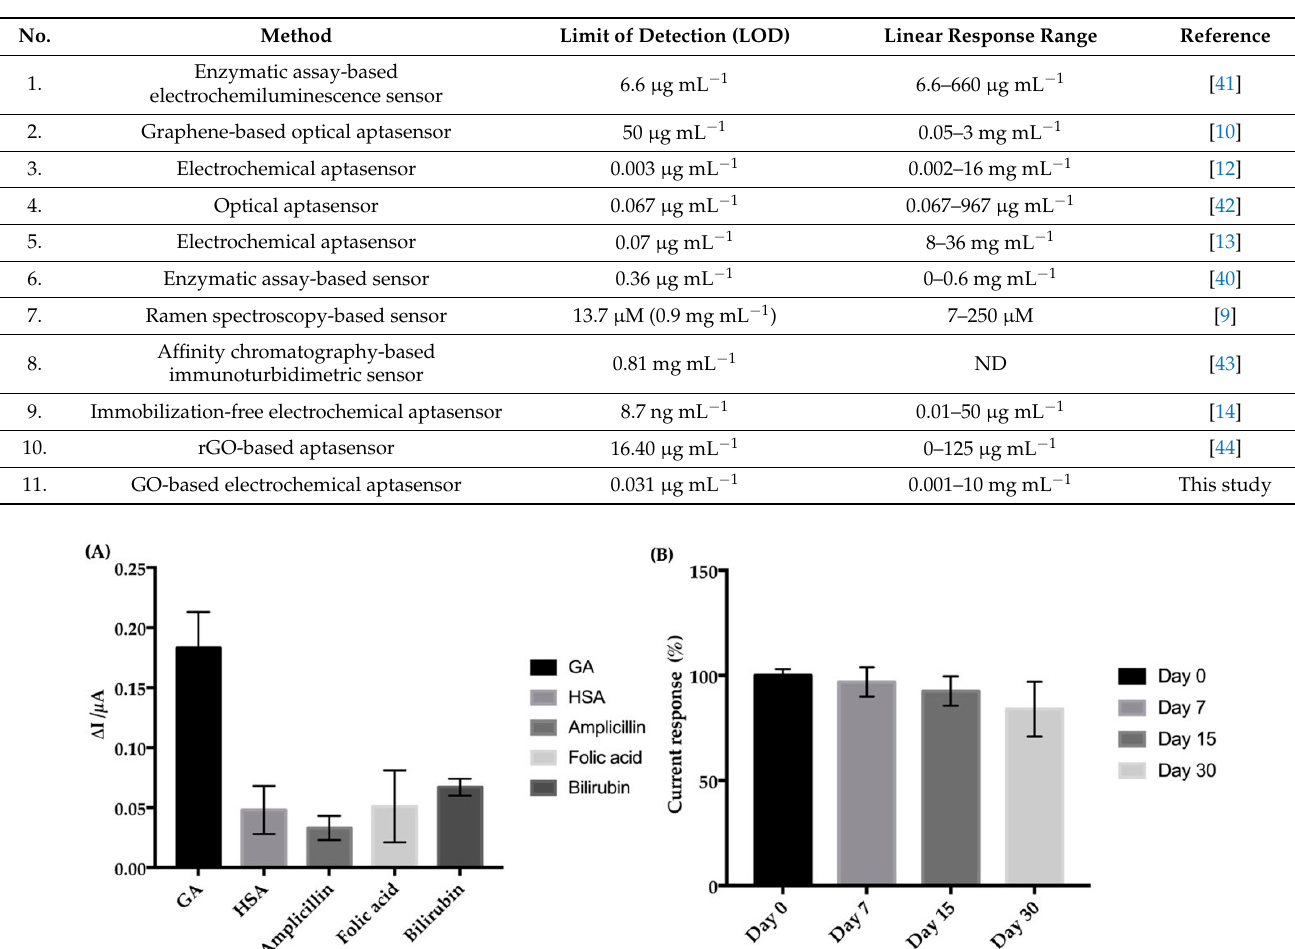
Table 1. Comparison of LOD from different biosensors for detection of glycated albumin.